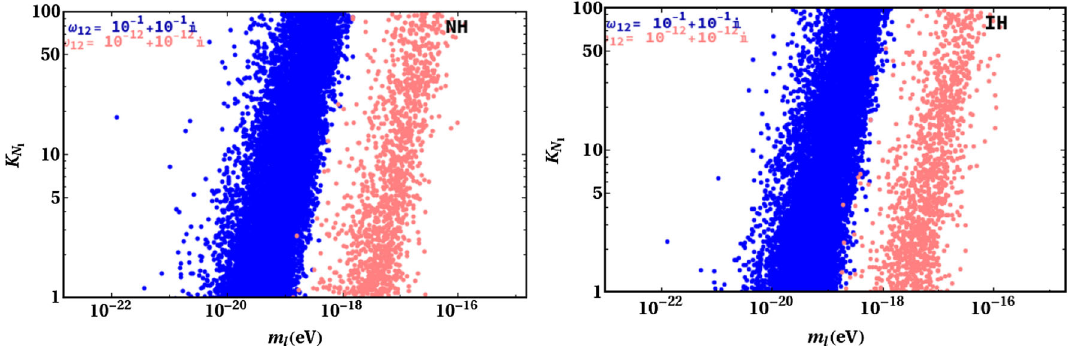
Fig. 5 Decay parameter K N ω = 10 − 3 + 10 − 3 i and ω 13 ω = 10 − 12 + 10 − 12 i . The results are similar for both the 12